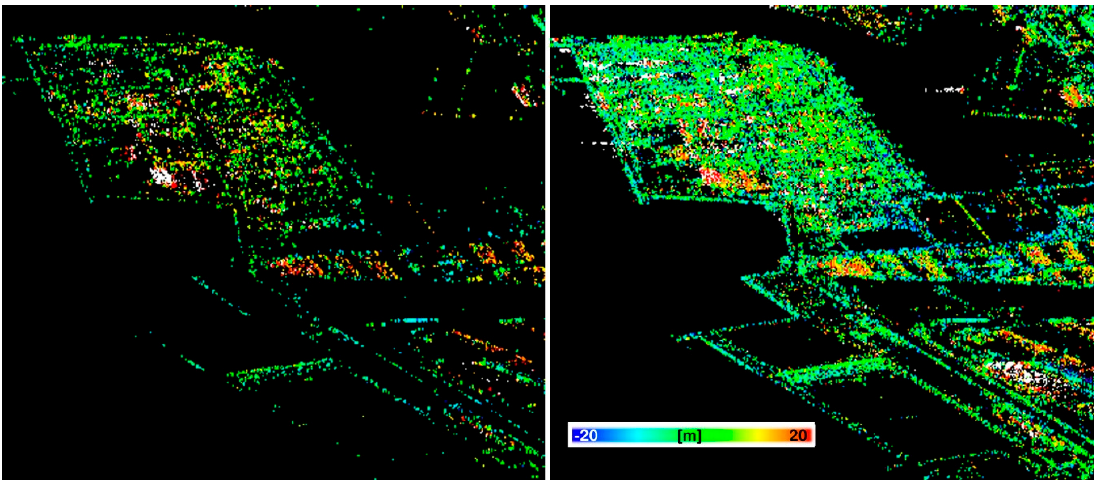
Figure 4. Residual topographic error (RTE) maps by PSI ( Left ) and by TomoSAR ( Right ).